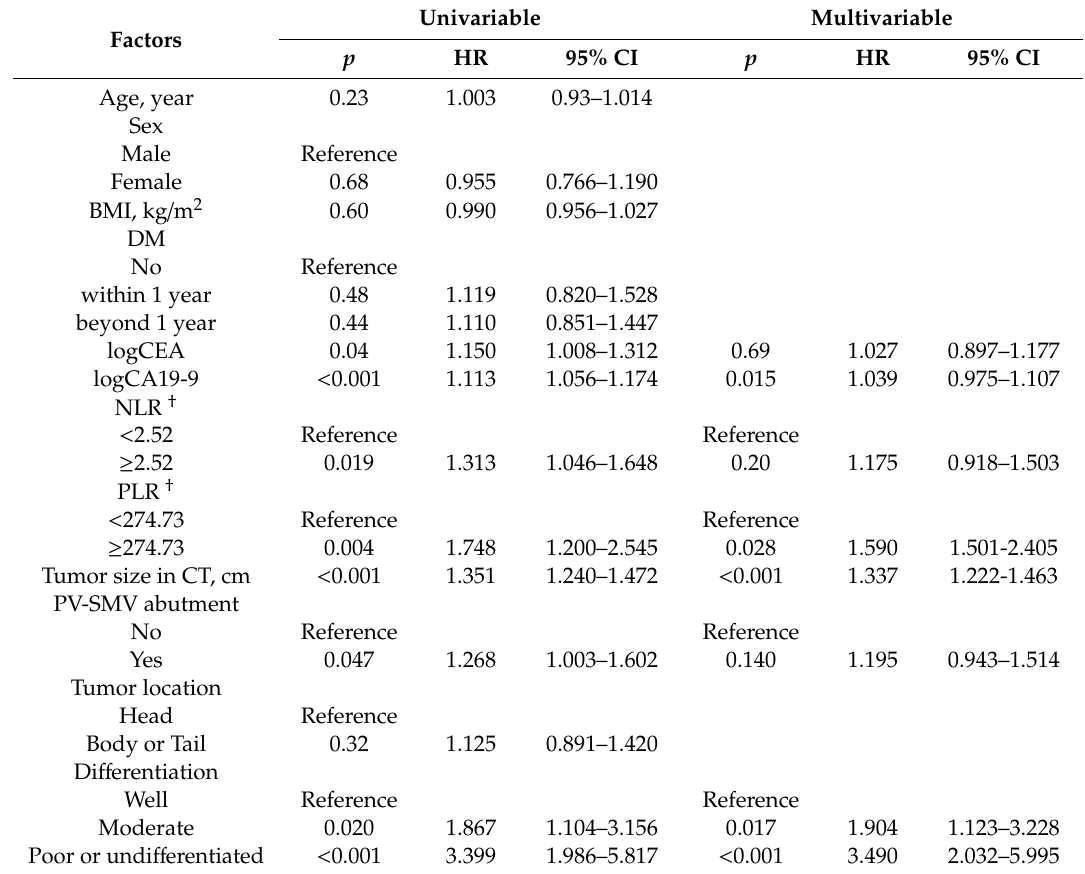
Table 2. Preoperative risk factor analysis in the training set ( n =